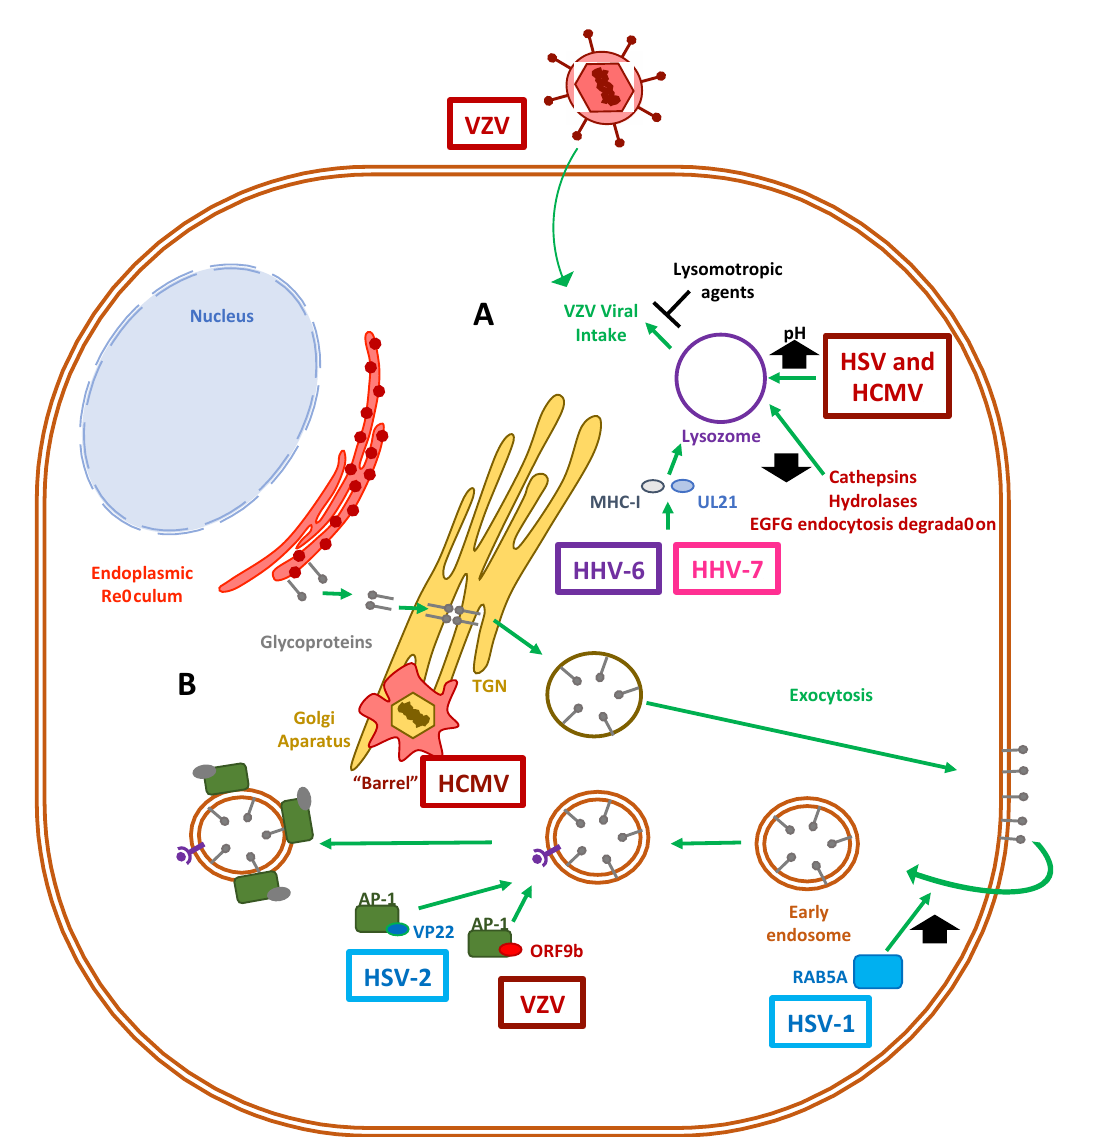
Figure 3. Human herpesvirus infection affects lysosome- and Golgi-sorting vesicle functions. ( A ) Lysosome activity has been shown to be crucial for herpesviruses infection. HSV and HCMV increase the pH levels of lysosomes in order to inactivate them. UL21 from HHV-6 and HHV-7 bind to MHC-I host proteins and divert them toward lysosomal degradation. VZV internalization has been shown to be inhibited by lysomotropic agents, suggesting a key role for the lysosomal pathway in the infection process mediated by this virus. HSV-1 inhibits key steps related to lysosome activation, such as cathepsin maturation, hydrolase activity and the EGFG-mediated endocytic pathway. ( B ) Capsid envelopment and glycoprotein maturation of herpesviruses occur through the Golgi apparatus and the trans-Golgi network (TGN). The corresponding viral proteins are transported to the cell membrane and then internalized into endosomes. This process has been described to be enhanced by means of the RAB5A protein by HSV-1. Clathrin-coated vesicles are transported into the cytosol, where the adapter protein 1 (AP-1) has been shown to interact with the VP22 and ORF9b proteins of HSV-2 and VZV, respectively. HCMV modifies the TGN, forming a barrel-like structure at the cis and trans sides of the Golgi apparatus.